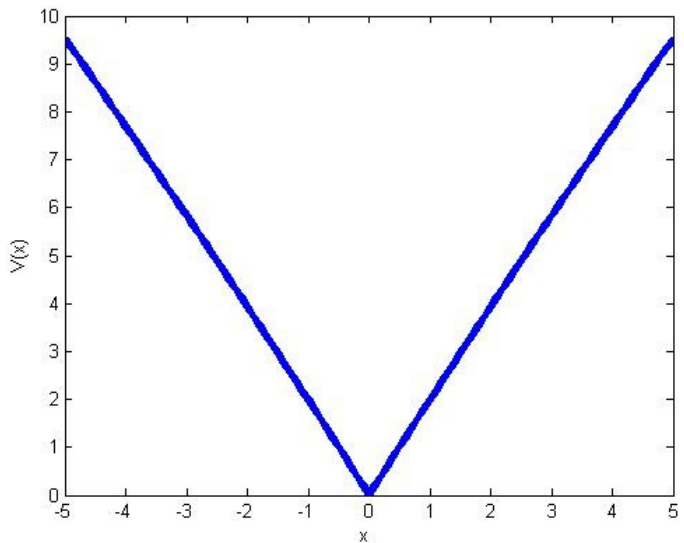
Figure 14. Variation of V ( x ) (Equation (20)) with x .